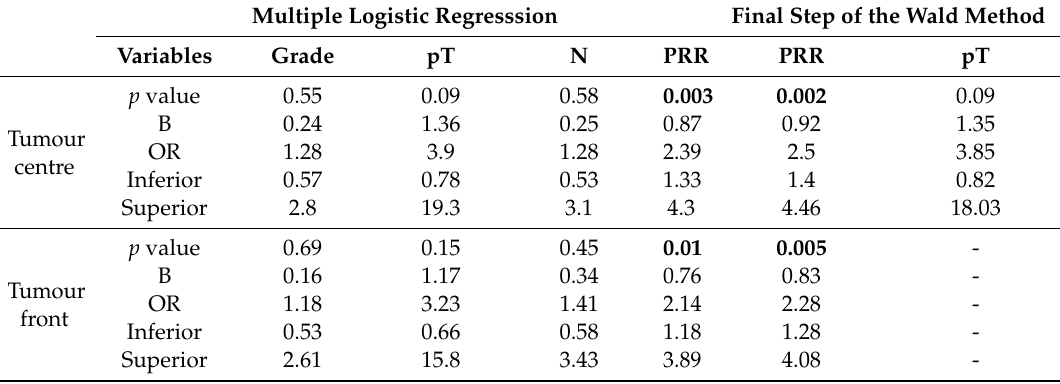
Table 6. Multiple logistic regression model for the prediction of metastasis presence in CRC patients at diagnosis time. A stepwise selection procedure (backward Wald method) was used to select the final optimal model. Odds ratios (ORs) and inferior and superior confidence intervals (CIs) are also included. According to the Omnibus test, the model was statistically significant ( p < 0.001 in the centre and p < 0.01 in the infiltrating front). Hosmer–Lemershow test p = 0.88 in the centre and p = 0.81 in the front). R 2 Nagelkerke 0.1 in the centre and 0.08 in the front. A 95% CI for OR was considered. Statistically significant values are highlighted in bold. Multiple Logistic Regresssion Final Step of the Wald Method Variables